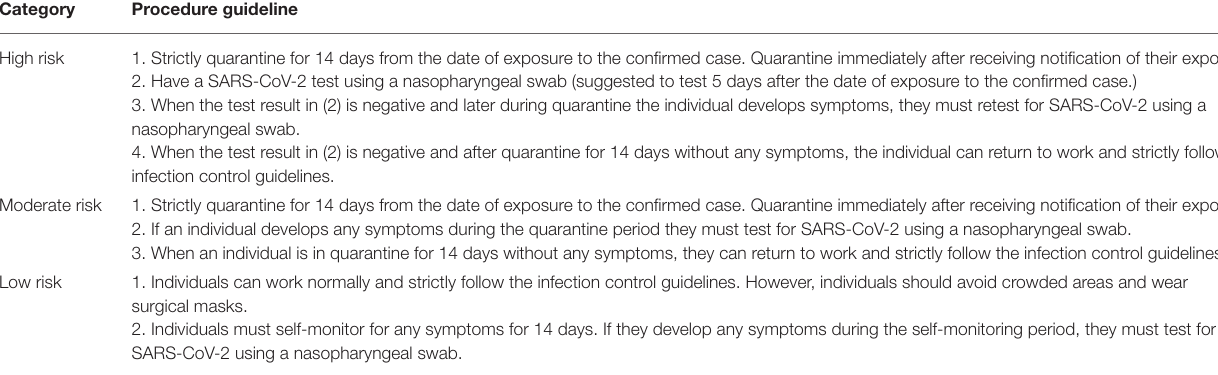
TABLE 1 | Procedure guidelines for individuals with high, moderate, and low risk of